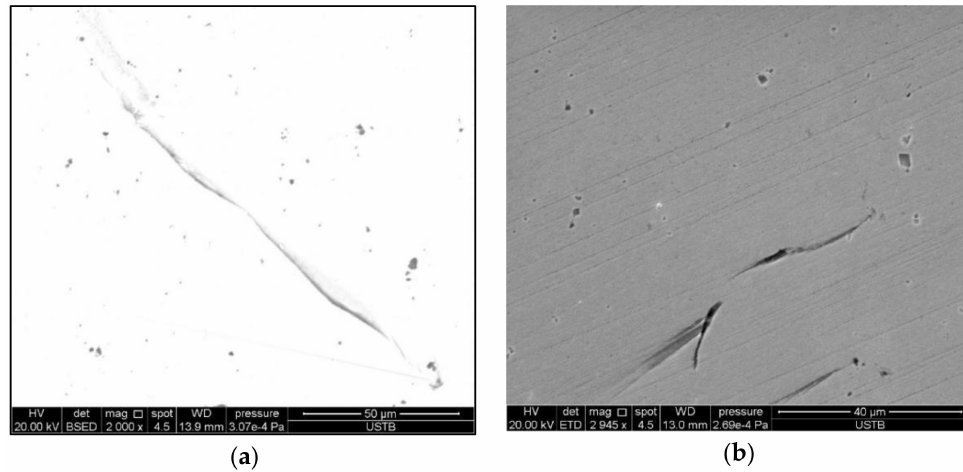
Figure 3. Microstructure of copper staves: ( a ) Backscatter imaging; ( b ) Secondary electron